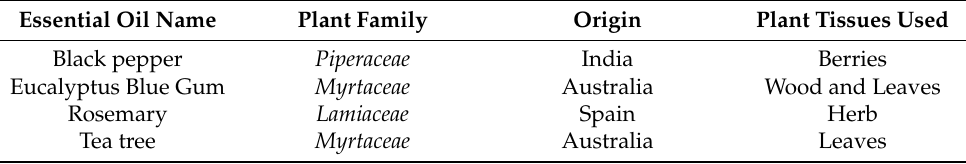
Table 5. List of essential oils used in this study, including origin and plant part